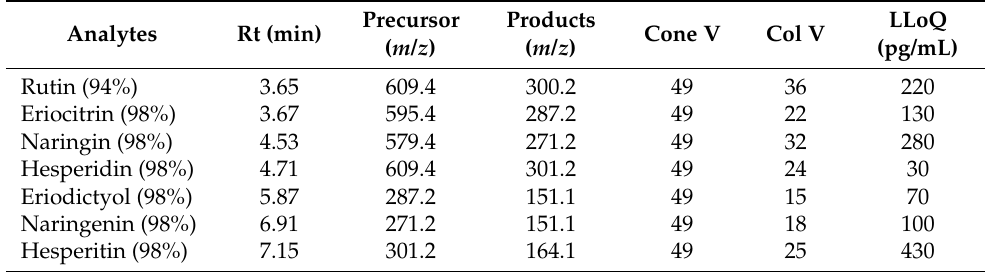
Table 2. Quantification MRM (Mass Spectrometry) and electrospray ionisation parameters of each analyte and LLoQ (lower limit of quantitation) based on 10 × S/N